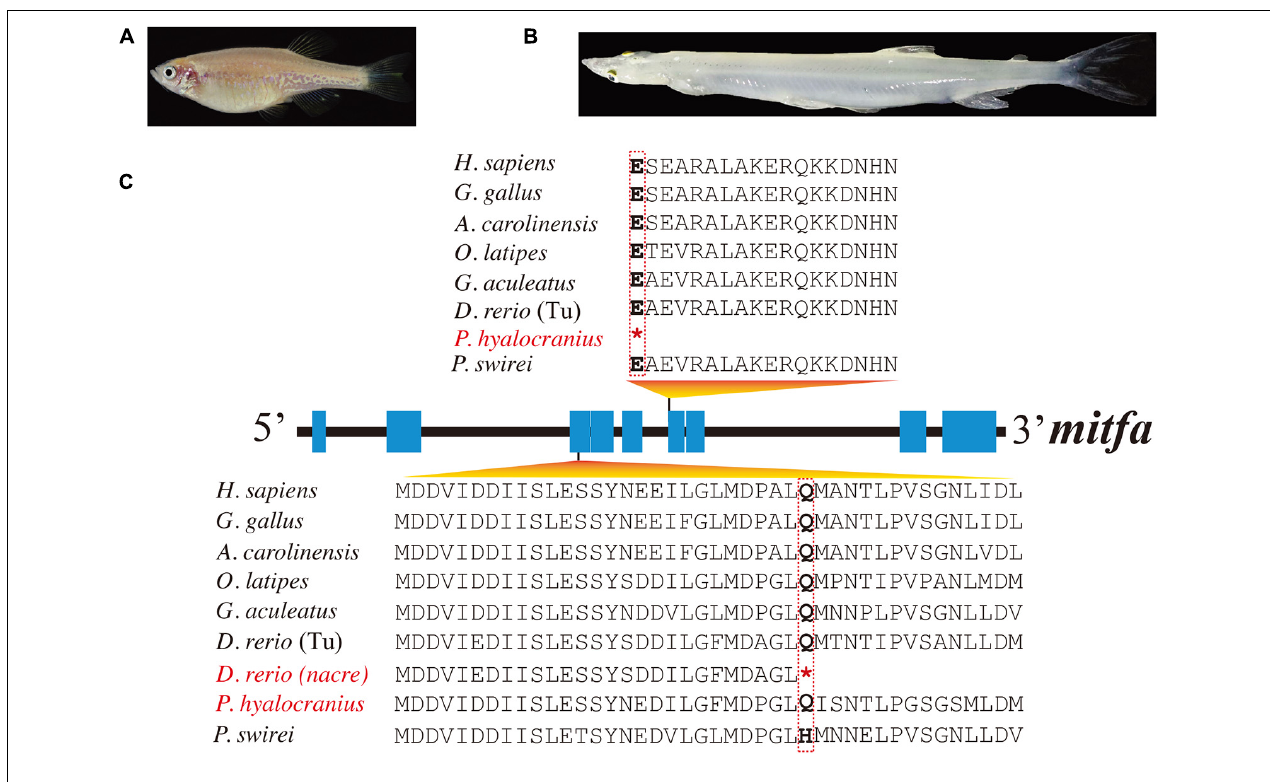
FIGURE 2 | Multiple sequence alignments of mitfa of nine representative species. (A,B) Photos of transparent nacre zebrafish and Chinese clearhead icefish ( P. hyalocranius ). (C) Nonsense mutations in the mitfa exons of both species. Species with melanin loss are marked in red. *Represents the premature stop codon.